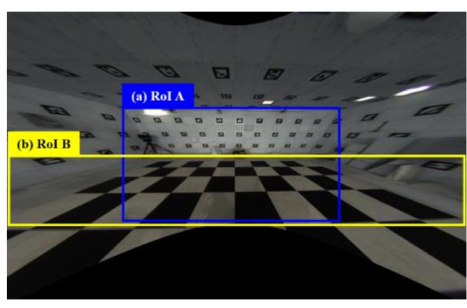
Figure 5. Undistorted